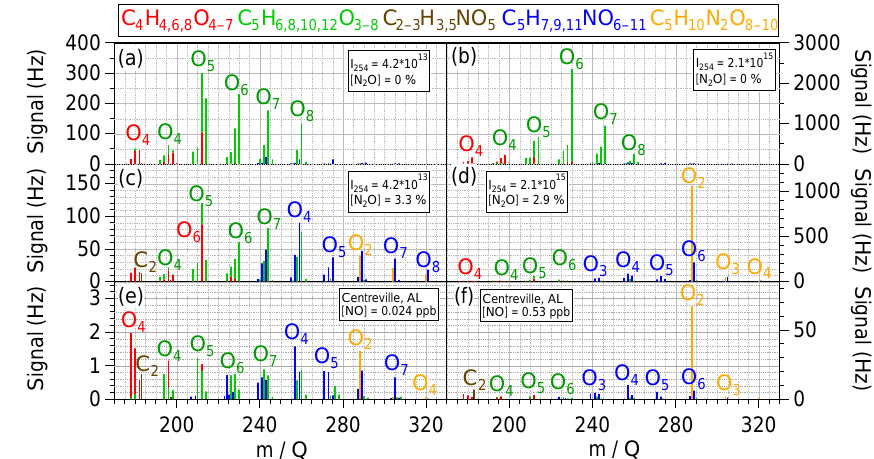
Figure 4. NO − -CIMS mass spectra of isoprene oxidation products generated in the PAM reactor at [H 2 O] = 1%, [O 3 ] = 5ppm, 3 and mean residence time = 80s: (a) I 254 = 4.2 × 10 13 phcm − 2 s − 1 , [N 2 O] = 0%; (b) I 254 = 2.1 × 10 15 phcm − 2 s − 1 , [N 2 O] = 0%; (c) I 254 = 4.2 × 10 13 phcm − 2 s − 1 , [N 2 O] = 3.2%; and (d) I 254 = 2.1 × 10 15 phcm − 2 s − 1 , [N 2 O] = 2.9%. NO − same compounds detected at the SOAS ground site in Centreville, Alabama, USA, during (e) “low-NO” and (f) “high-NO” conditions (see text for additional details; C 5 H 6 O 5 − 7 ions removed from SOAS spectra due to larger contributions from α -pinene + OH oxidation products; Fig. 6). “C x ” or “O x ” indicates number of carbon or atoms in labeled ions (not including oxygen atoms in nitrate functional